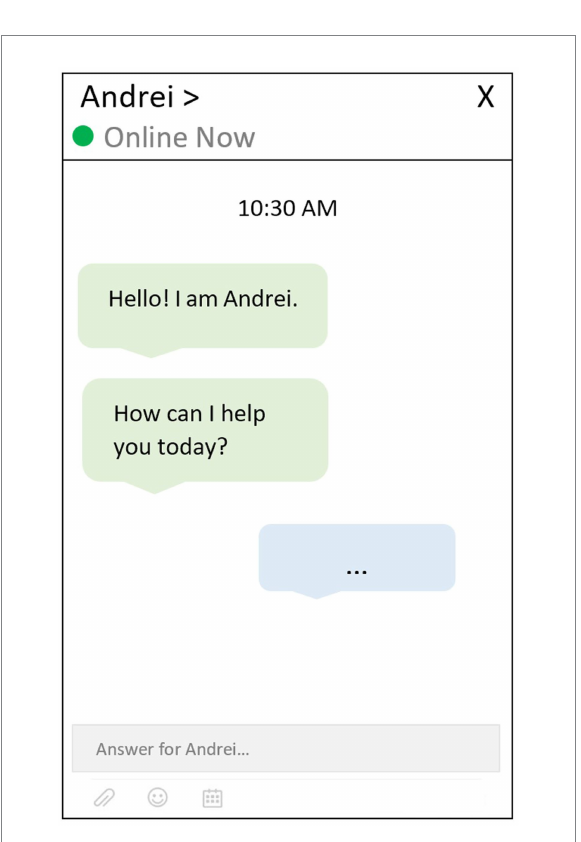
FIGURE 2 An example of chatbot interaction given within the